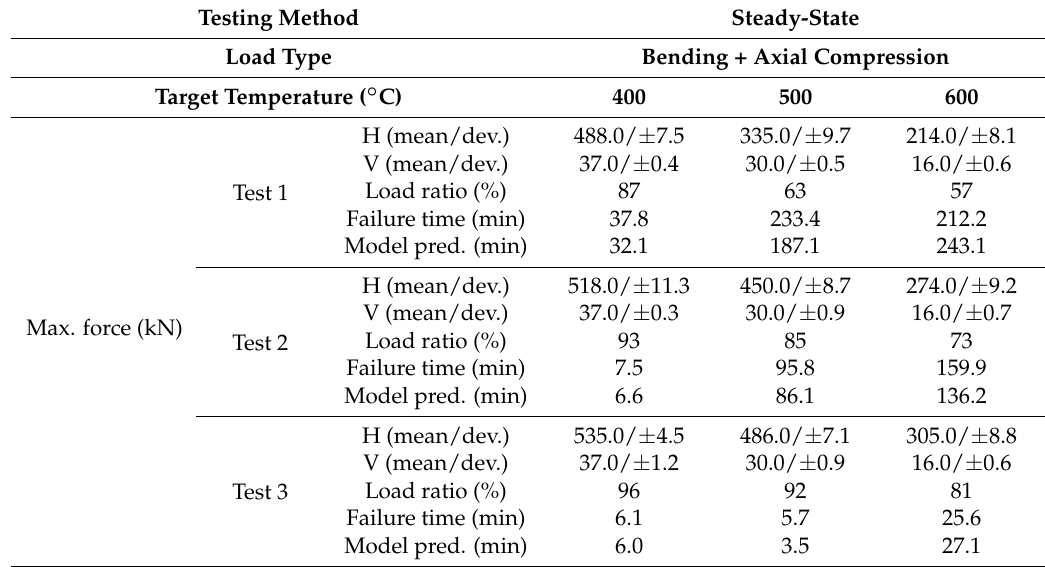
Table 2. Summary of test results for column creep